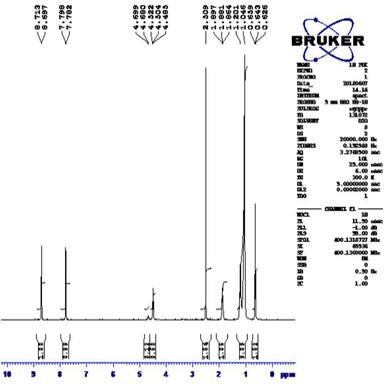
FTNMR spectrum of pure DMPI ( 1 H).